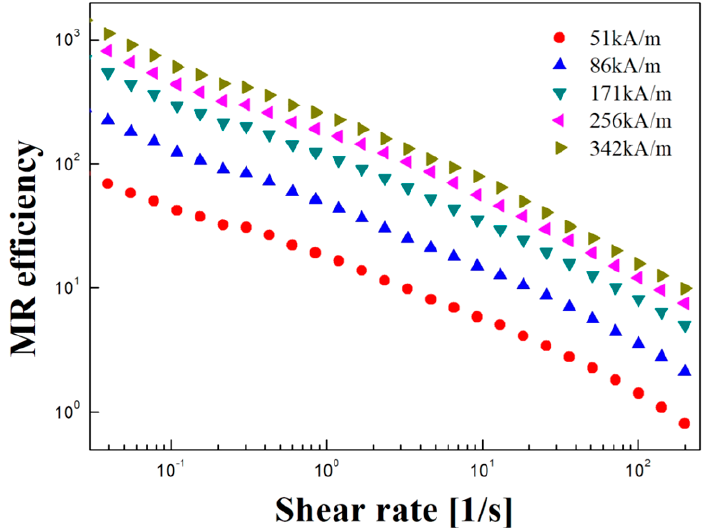
Figure 7. MR efficiency of Fe 3 O 4 /POA based MR suspension.